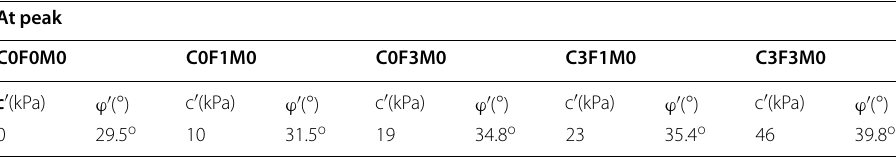
Table. 6 Mohr-Coulomb strength parameters, c ′ p and ϕ ′ p , for unreinforced, fibre reinforced, and fibre reinforced cemented Toyoura sand from CID extension tests At